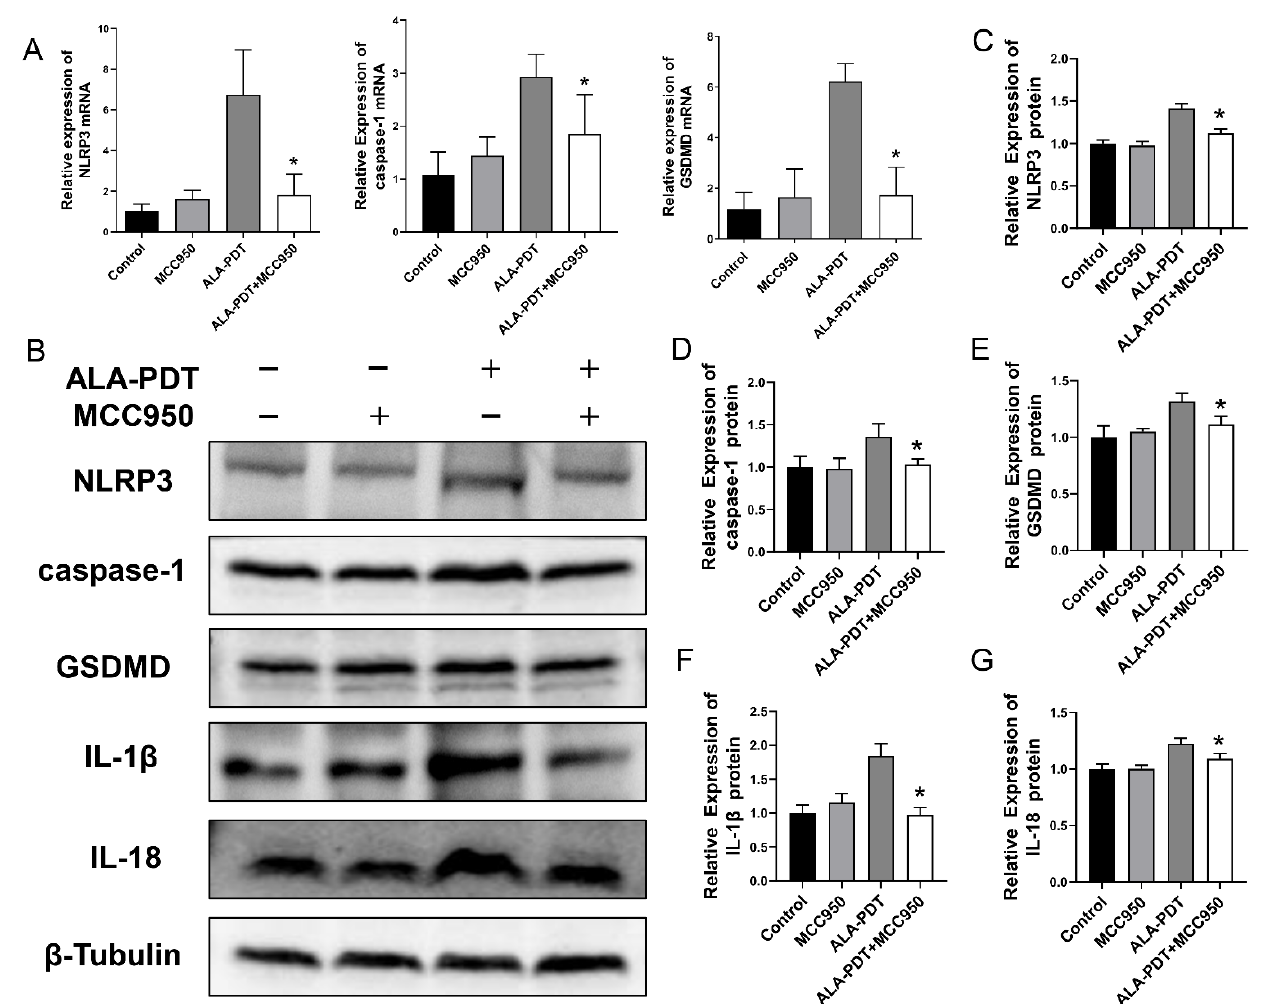
Figure 6. MCC950 suppressed ALA-PDT-induced pyroptosis. ( A ) The mRNA expression of NLRP3, caspase-1, and GSDMD was detected by qPCR. * p < 0.05 compared with ALA-PDT group. ( B ) The protein expression of NLRP3, caspase-1, GSDMD, IL-1 β , and IL-18 was detected by western blot. ( C – G ) Statistical analysis of the protein levels of NLRP3, caspase-1, GSDMD, IL-1 β , and IL-18. * p < 0.05 compared with ALA-PDT group.